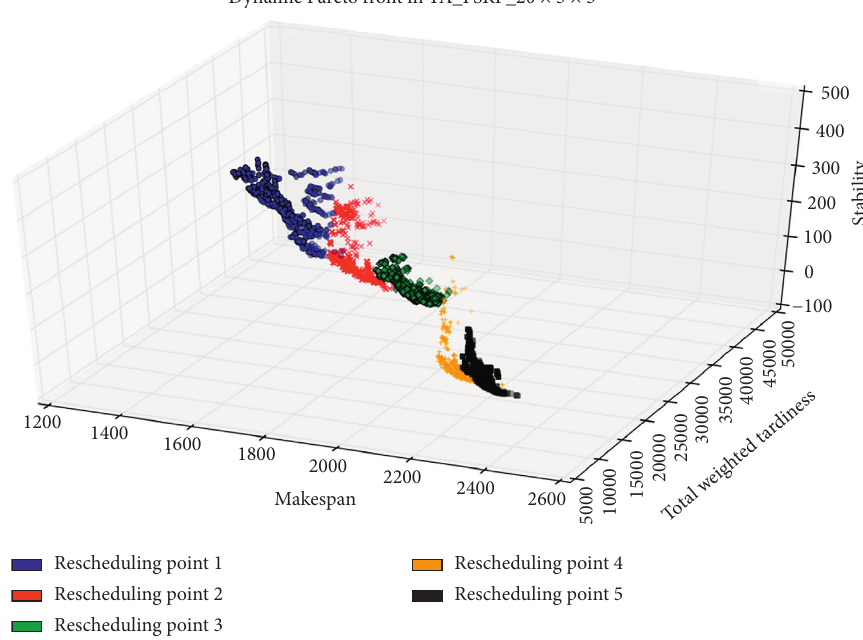
Figure 11: RIPG Pareto front in